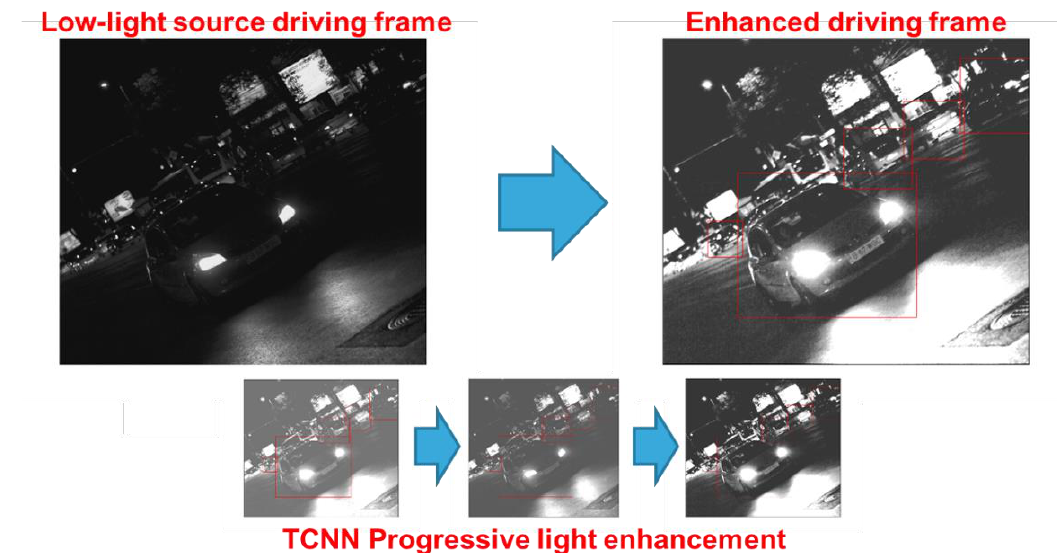
Figure 7. A detail of the enhanced low-light driving frames with embedding bounding-box (red box) and light-processing performed by the proposed TCNN as per Equations (5) – (7).